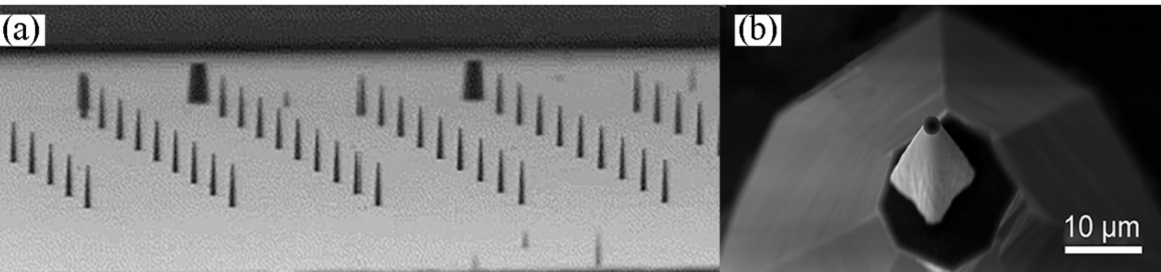
Figure 4. APT Si holder. ( a ) APT Si holders; ( b ) single APT Si holder.